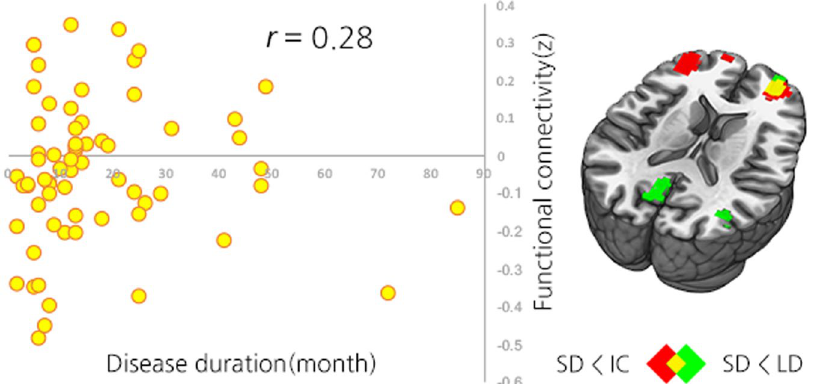
Figure 3. Correlation graph between the duration of parkinsonism before MCI diagnosis and rsFC between the bilateral SI seed and conjunction mask of the bilateral frontal areas ( r = 0.28, P = 0.023). Abbreviations: PD-MCI-SD = Parkinson’s disease with a shorter duration of parkinsonism before mild cognitive impairment diagnosis; PD-MCI-LD = Parkinson’s disease with with a longer duration of parkinsonism before mild cognitive impairment diagnosis; PD-IC = Parkinson’s disease with intact cognition; rsFC = resting-state functional connectivity; SI = Substantia